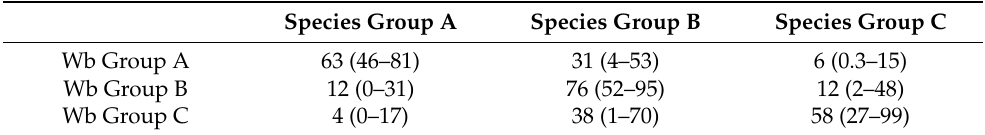
Table 3. Summarized percentage of abundance for three groups of characteristic species in three groups of waterbodies: mean (min-max). Wb = water